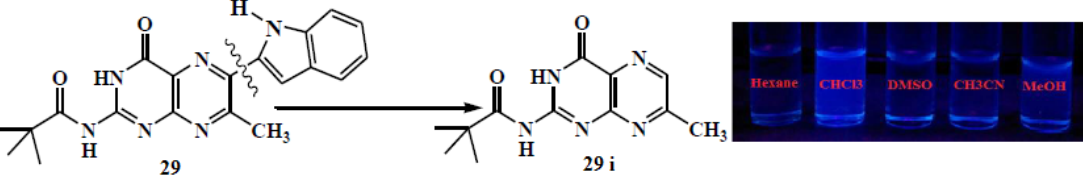
Figure 21: Naked eye fluorescence change of 29a (7- methyl pterin) with different Solvents (ref. 57)